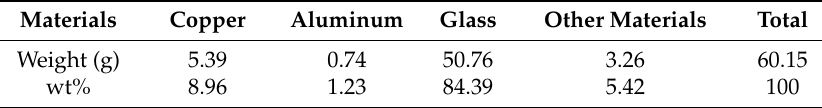
Table 1. Composition of the automobile shredder residue (ASR)